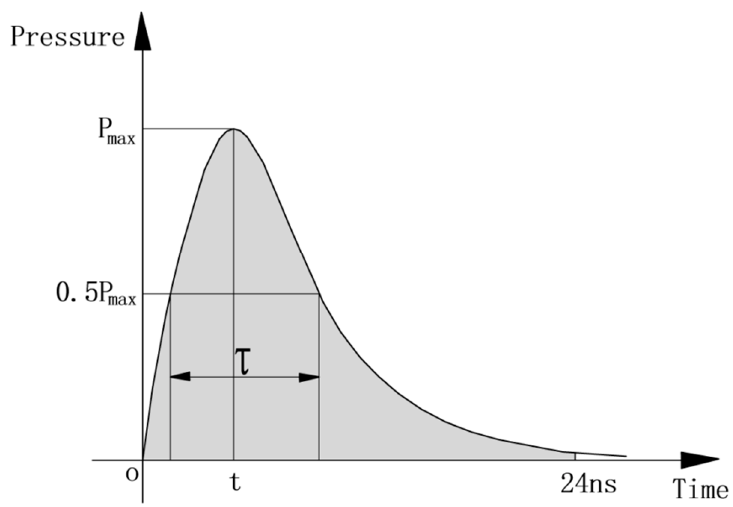
Figure 4. The curve of laser induced shock wave pressure changing with the time.